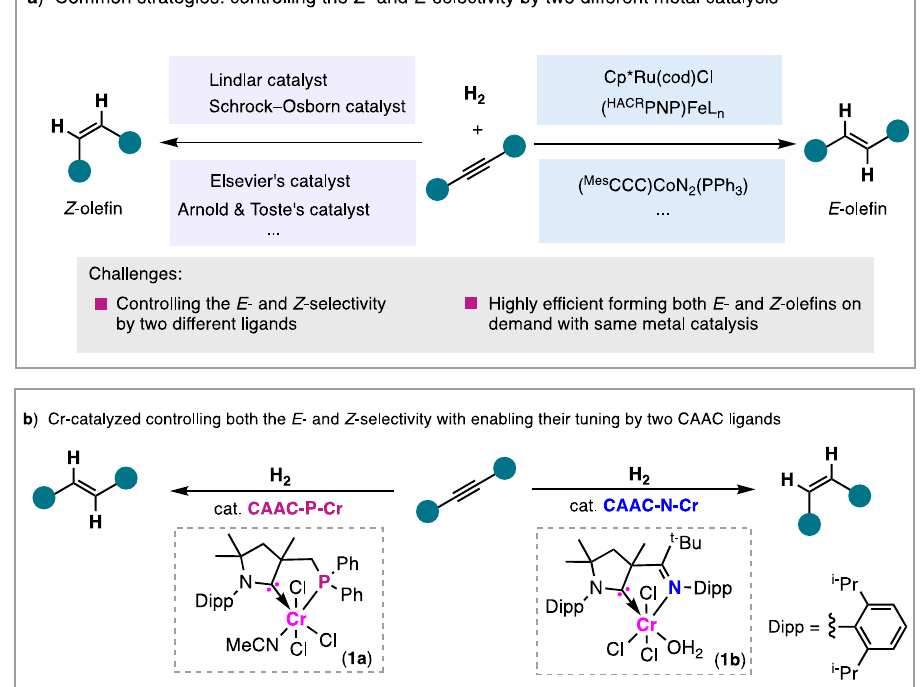
Z -selectivity in the hydrogenation of alkynes by two CAAC ligands. CAAC cyclic (alkyl)(amino)carbene, CAAC-P – Cr CAAC-phosphino-ligated Cr complex 1a , CAAC-N – Cr CAAC-imino-ligated Cr complex 1b